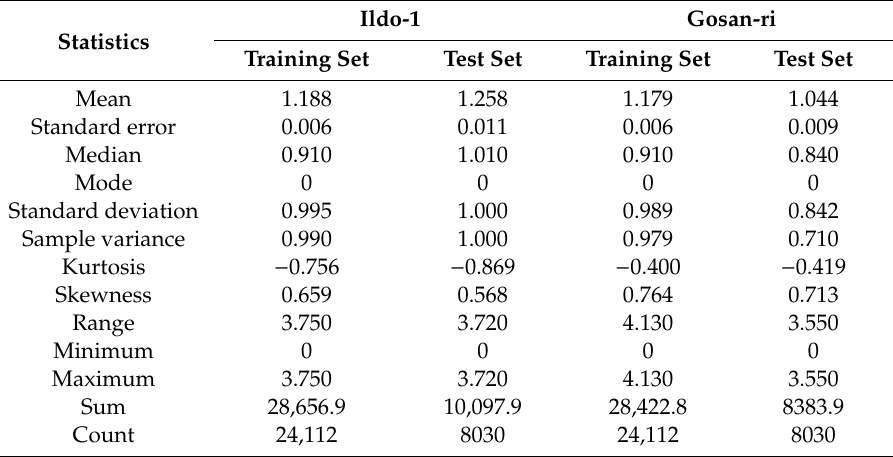
Table 3. Statistical analysis of global solar radiation data by region (MJ/m 2